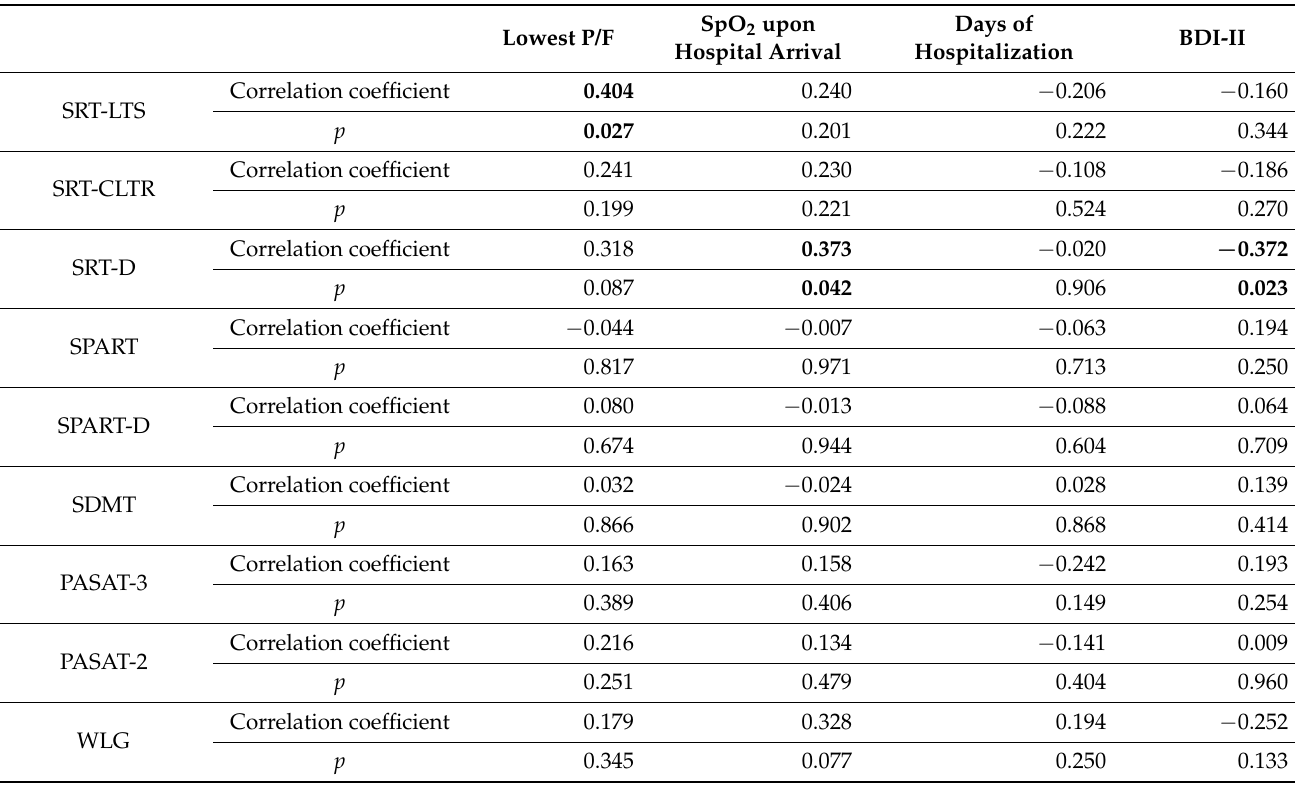
Table 3. Correlations between neuropsychological test scores and clinical